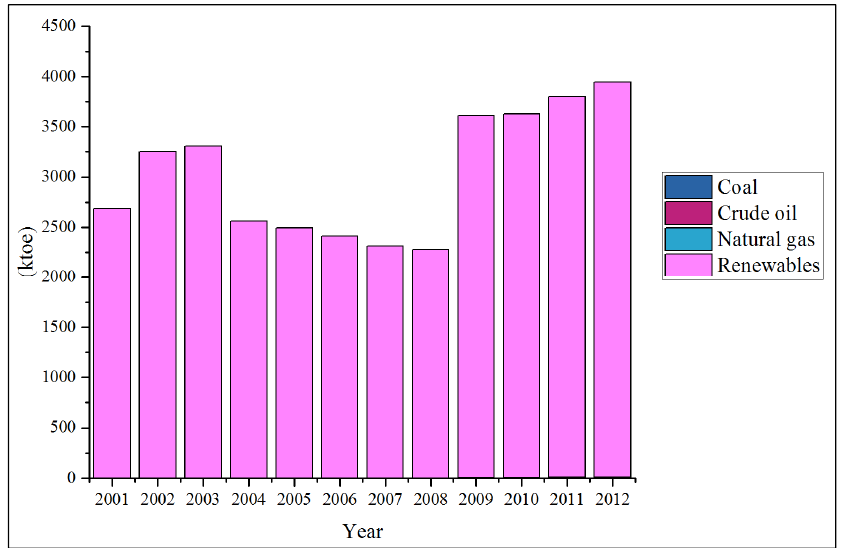
Figure 2. Cambodia: primary energy